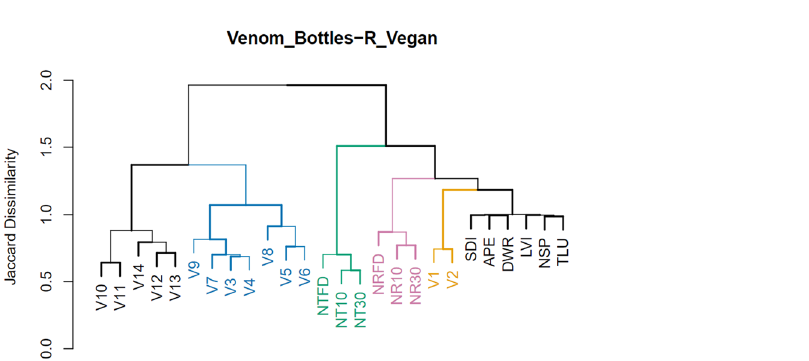
Figure 2. Miniature vessels: Paneled flask with narrow aperture (V11), Sculpted flask with narrow aperture (V12), Sculpted flask with wide aperture (V13).